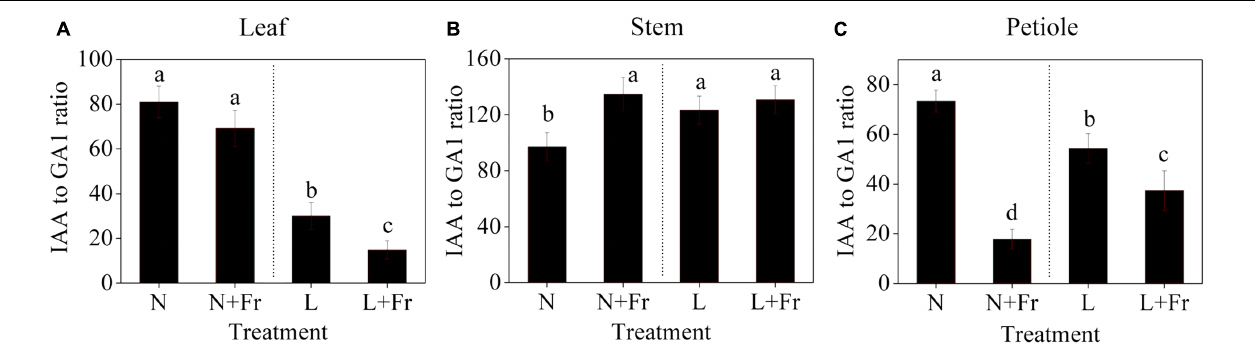
FIGURE 6 | IAA-to-GA1 ratios in the different tissues [leaf (A) , stem (B) , and petiole (C) ] of soybean seedlings harvested after 15 days under different light intensity and quality treatments. The leaves and petioles were obtained from the second trifoliolate leaves, and the stem samples were collected from the top internodes. N, N+Fr, L, and L+Fr denote normal light (normal PAR and normal R/Fr ratio), normal light plus far-red light (normal PAR and low R/Fr ratio), low light (low PAR and normal R/Fr ratio), and low light plus far-red light (low PAR and low R/Fr ratio), respectively. Each value is expressed as the mean ± SE. The means for each treatment that do not have a common letter are significantly different at P = 0.05, according to Duncan’s multiple range test.